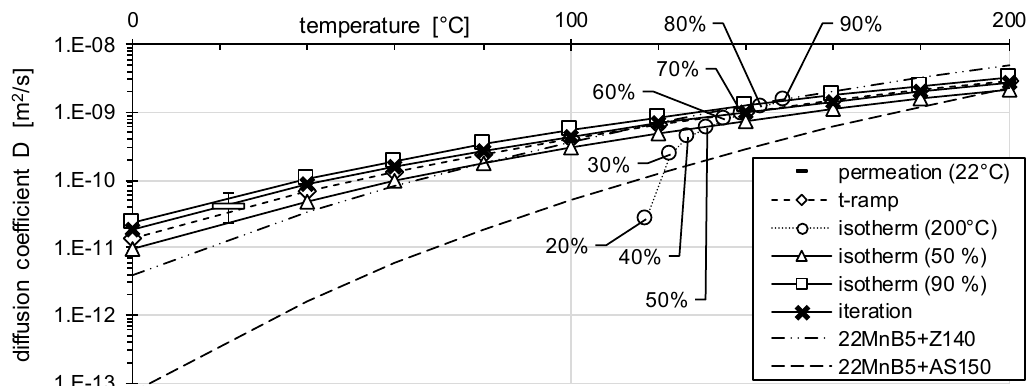
Figure 22. Summary and comparison of the determined diffusion velocities for 22MnB5.